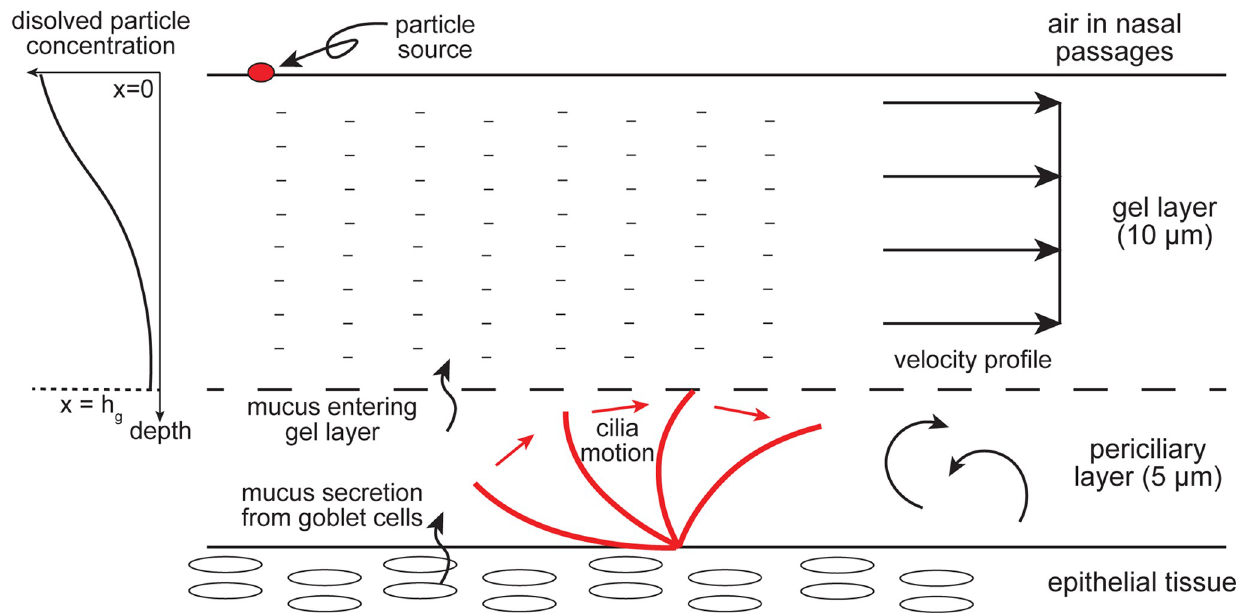
Fig 13. Schematic of the mucus layer structure and dissolved drug particle diffusion through the gel layer. The mucus model and the diffusion model were reproduced from studies of Shang et al. [25] and Erickson et al. [26].